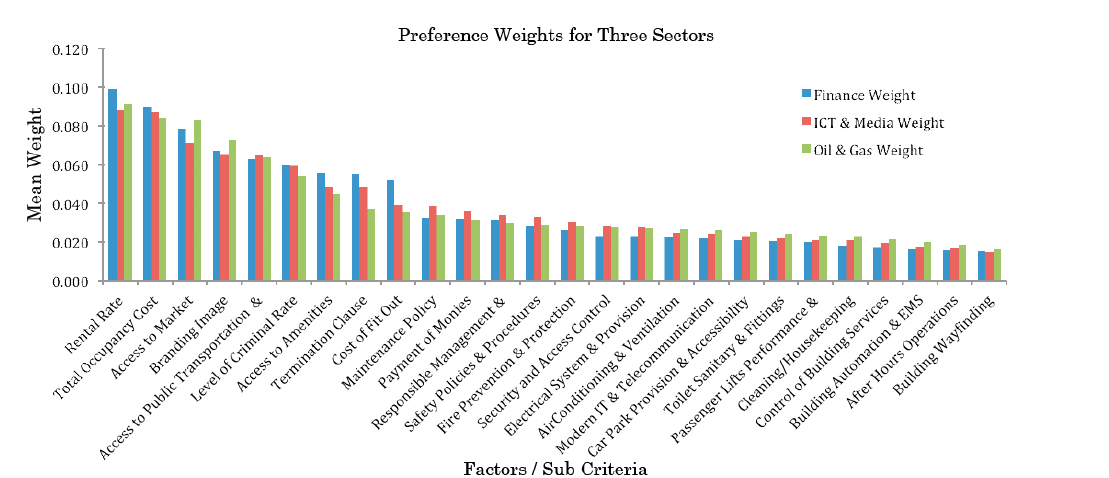
Fig. 2. Overall preference weights between the three